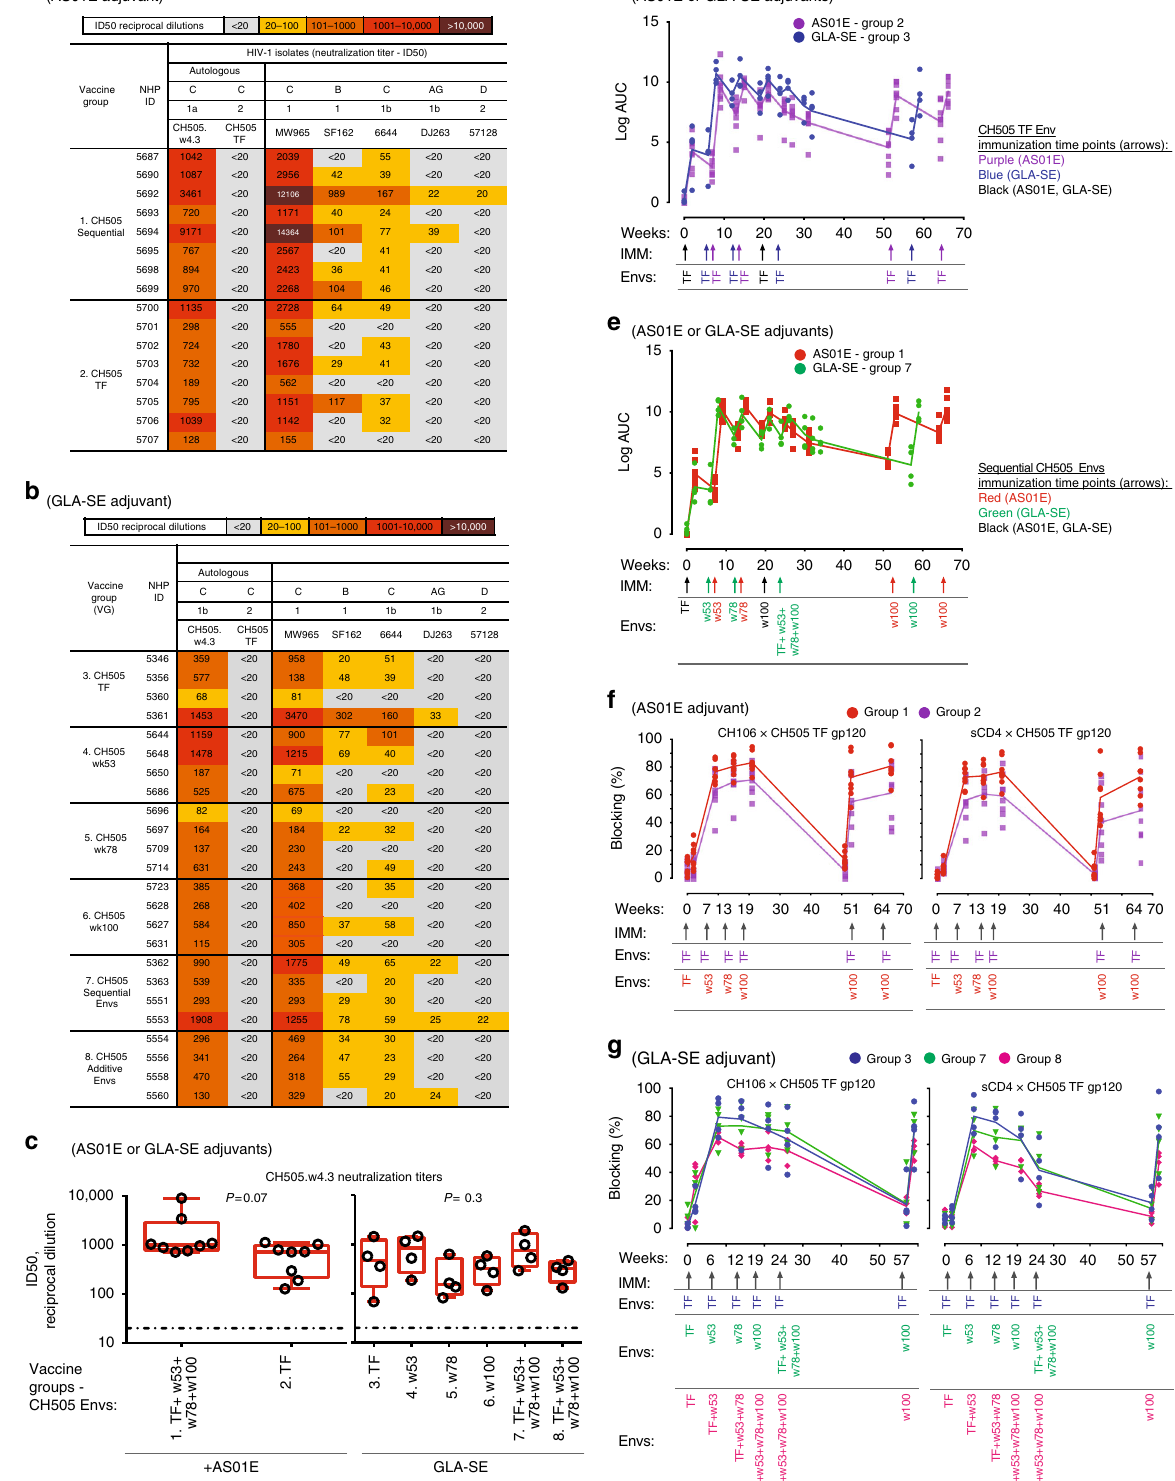
CH505 TF Env immunization time points (arrows): Purple (AS01E) Blue (GLA-SE) Black (AS01E, GLA-SE)